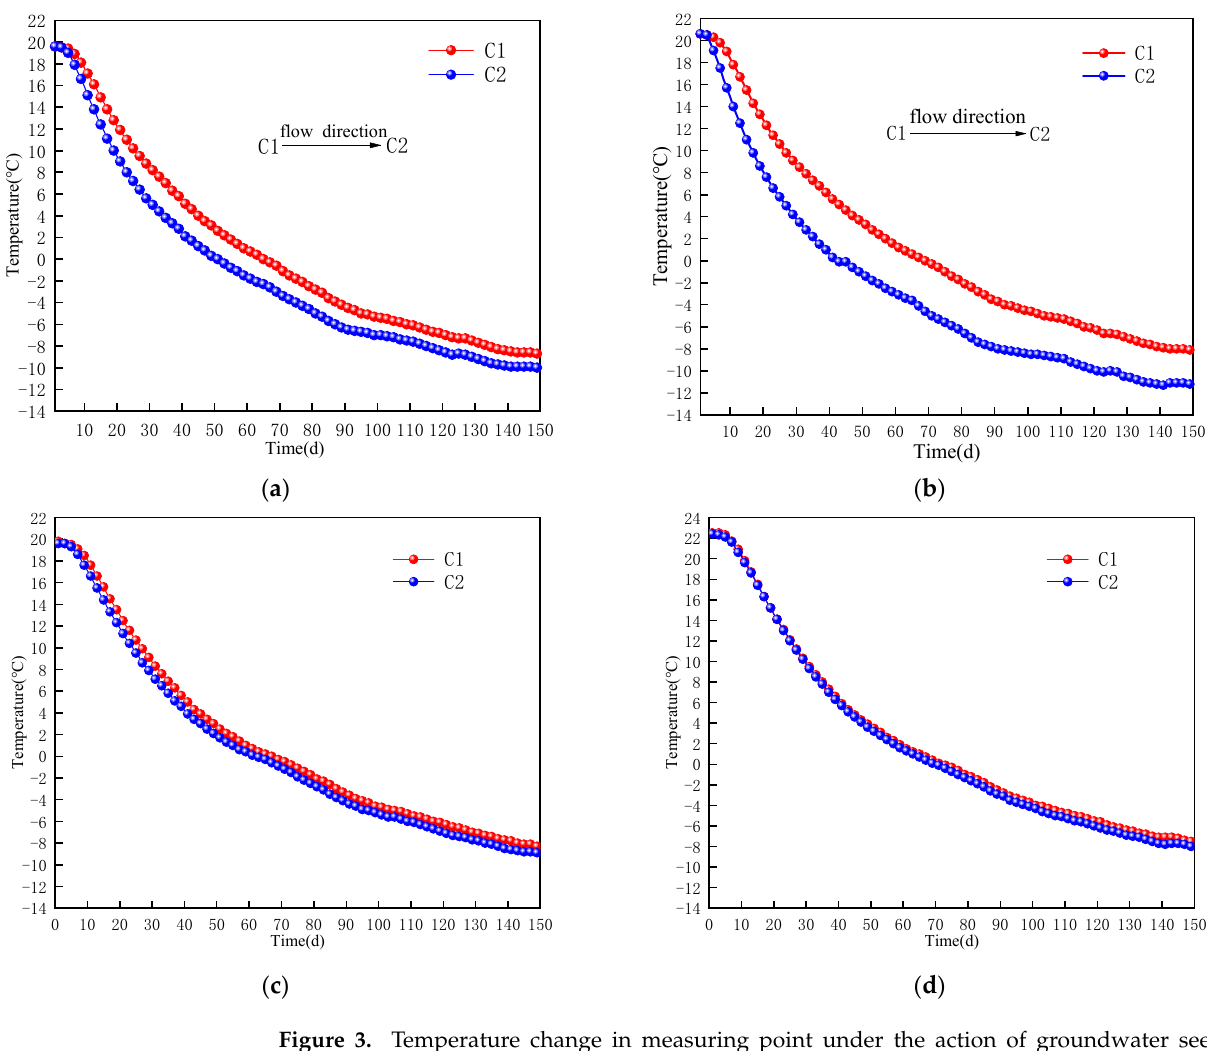
Figure 3. Temperature change in measuring point under the action of groundwater seepage. ( a ) -87 m fine sand; ( b ) − 135 m fine sand; ( c ) − 97 m clay; ( d ) − 215 m clay.